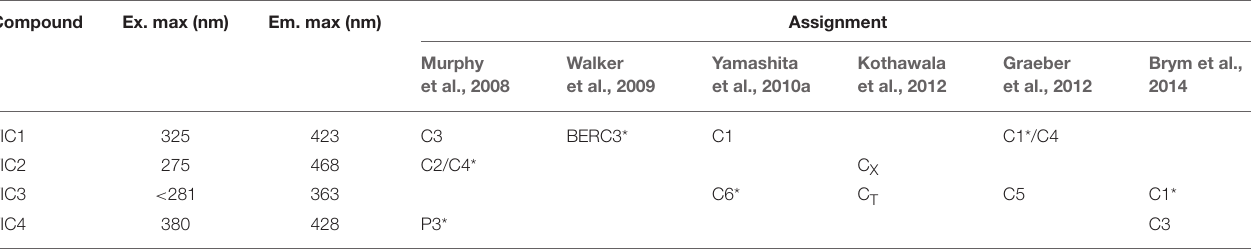
TABLE 2 | Optical characteristics of five components derived from the PARAFAC and their comparison with the results from previous studies available in the OpenFluor database (Murphy et al., 2014). Compound